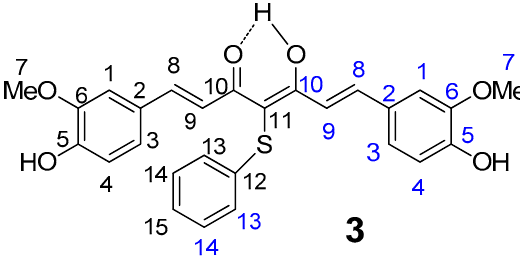
Figure 10. Structure of Compound 3.